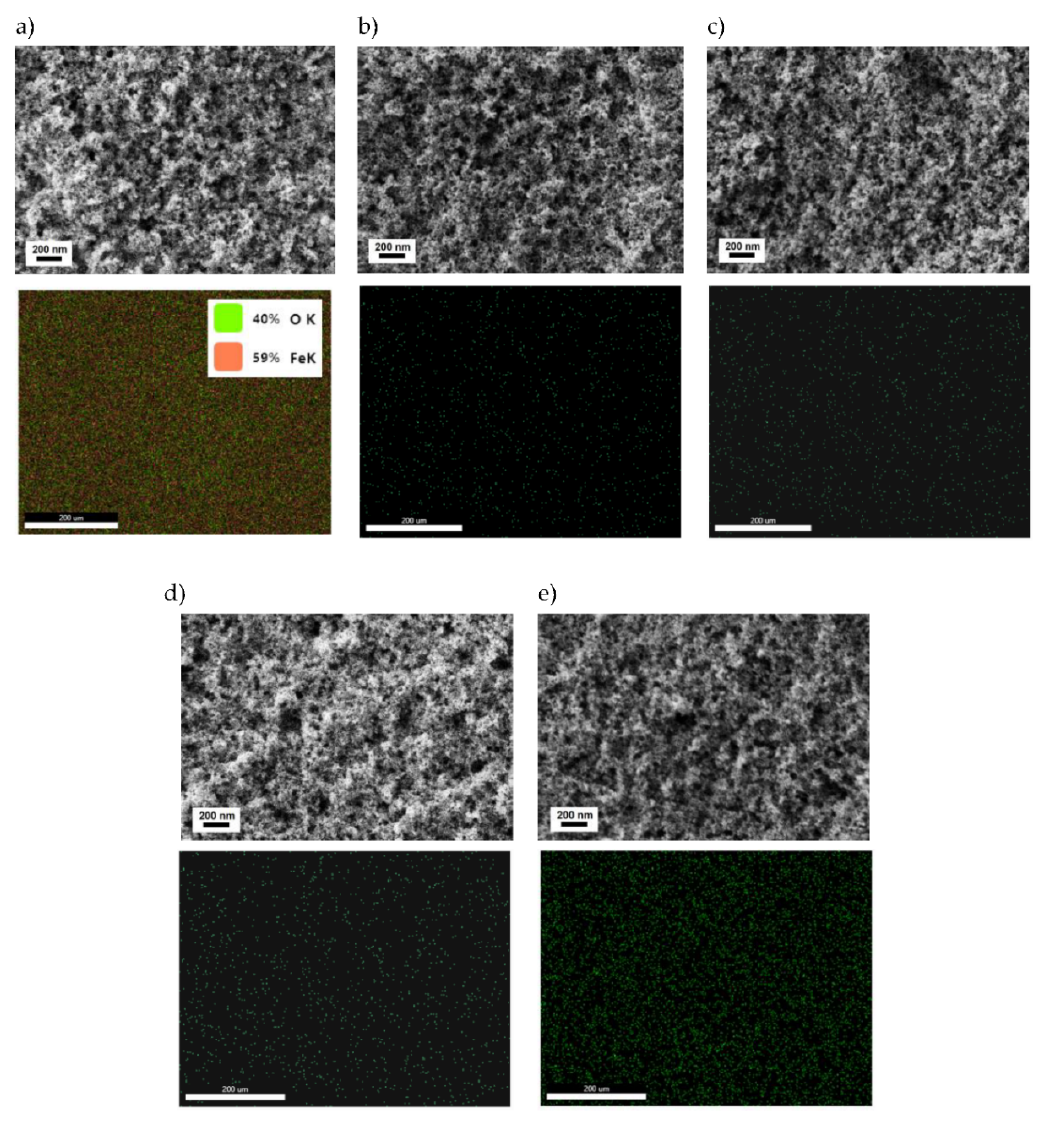
Figure 1. SEM images and EDS map for ( a ) Fe 3 O 4 , ( b ) Fe 3 O 4 @1%Zn, ( c ) Fe 3 O 4 @2%Zn, ( d ) Fe 3 O 4 @5%Zn, and ( e ) Fe 3 O 4 @10%Zn. EDS maps for doped samples b–d) show the Zn distribution in the nanoparti- cles.